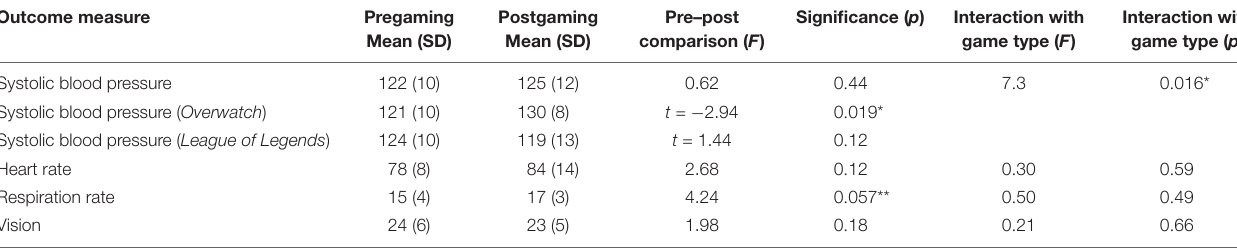
TABLE 2 | Pregaming and postgaming comparison of physiological outcome variables with F statistic and p